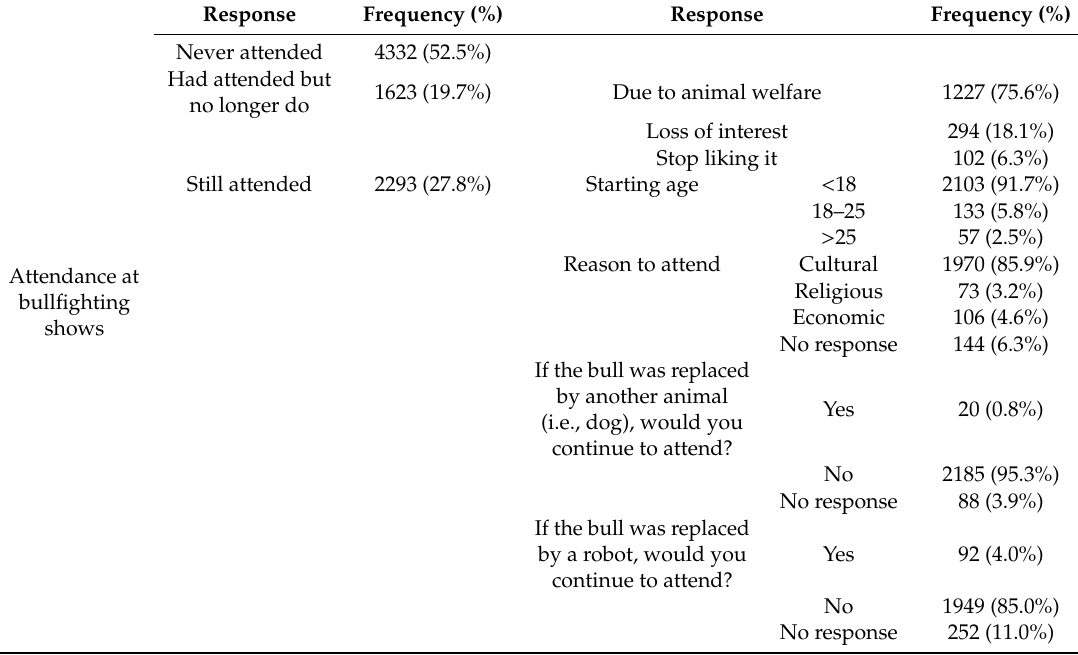
Table 3. Summary of respondents’ attendance at bullfighting events (N = 8248